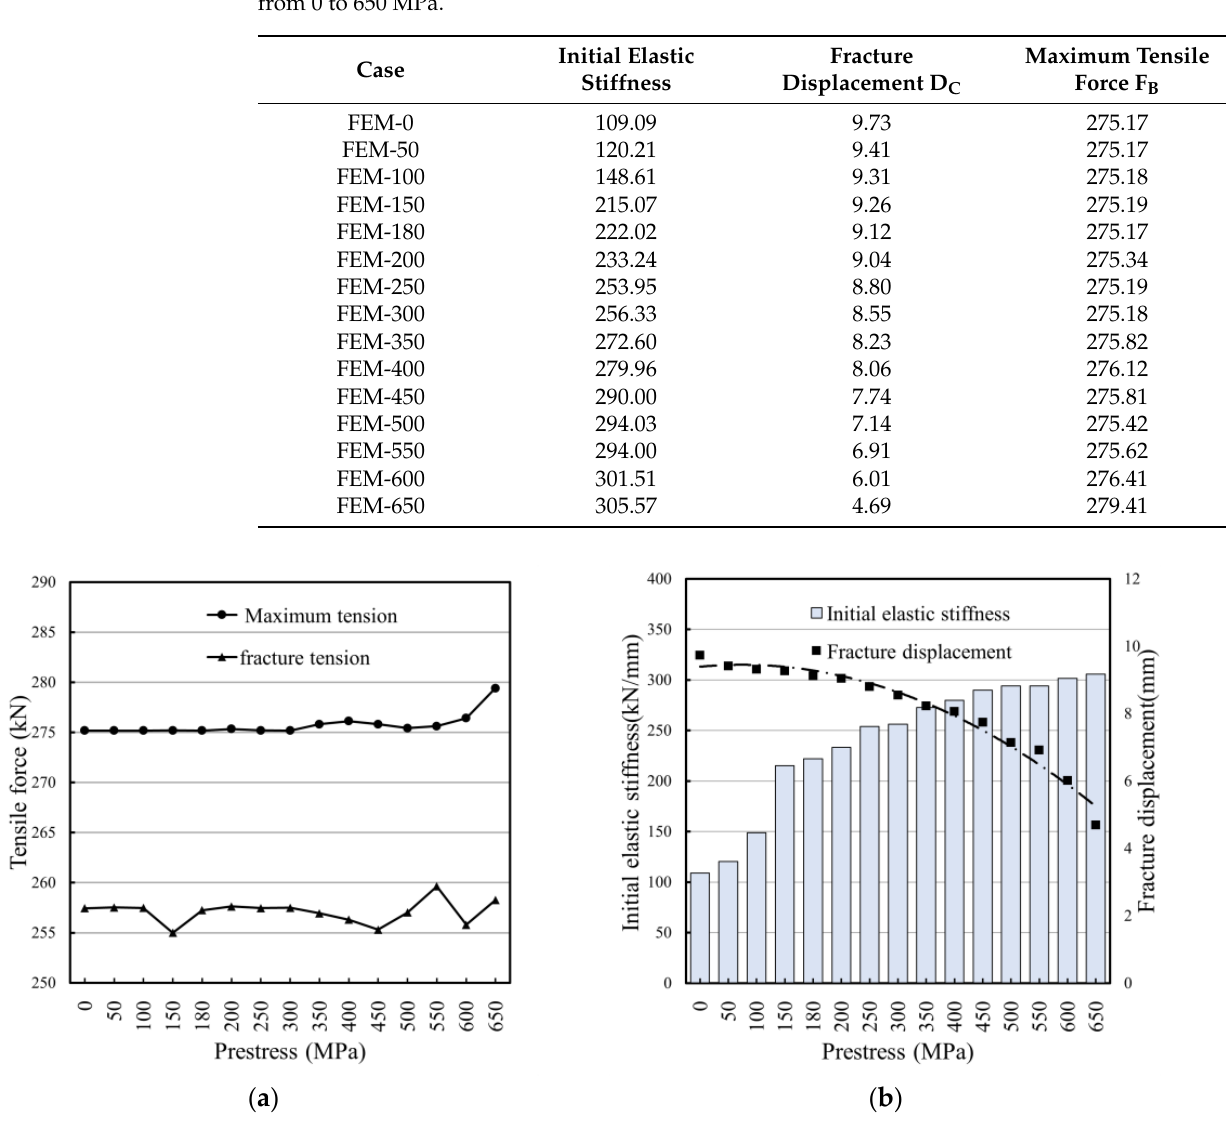
Table 9. The failure parameters of VCSB connection structure under tensile load with the prestress from 0 to 650 MPa.